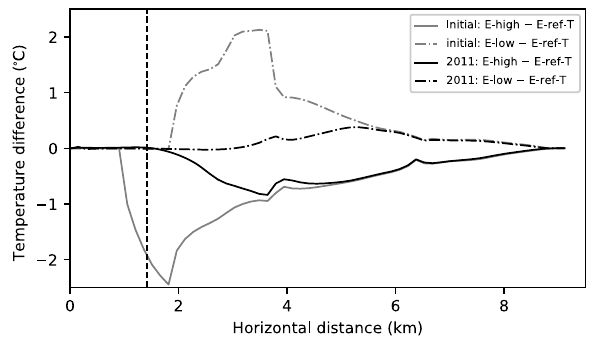
Figure 12. Differences of the column mean temperatures along the CL between the sensitivity experiments (E-high and E-low) and the reference experiment (E-ref-T). Gray lines indicate the initial tem- perature differences, whereas black lines indicate the temperature differences in